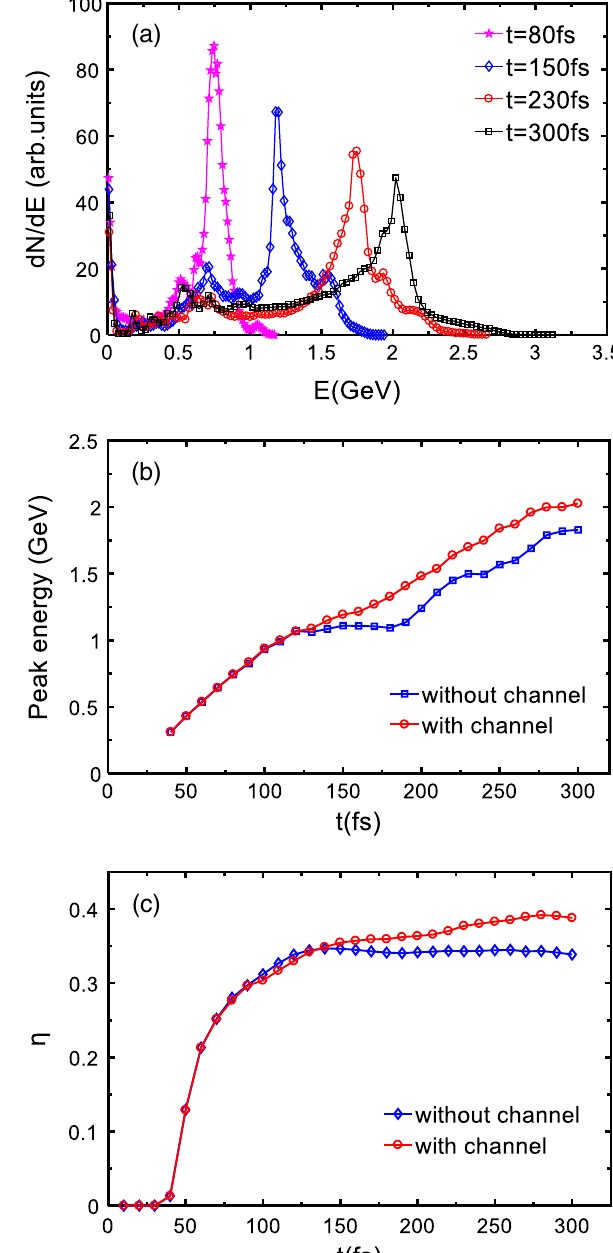
FIG. 6. (a) Energy spectrum of the proton for the case with a channel at four time instants: t ¼ 80 fs, t ¼ 150 fs, t ¼ 230 fs, and t ¼ 300 fs. Temporal evolution of peak energy (b) and energy conversion efficiency (c) for both cases, respectively. Here, the protons in the region of − 6 λ ≤ y ≤ 6 λ are chosen as statistical